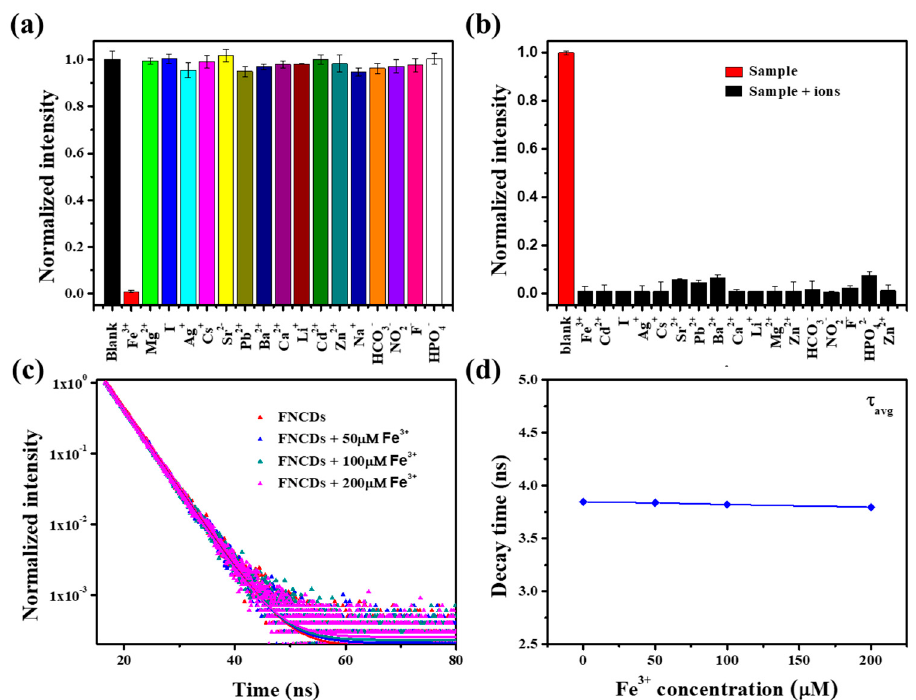
Figure 4. ( a ) Fluorescence intensity of FNCDs in the presence of different ions. ( b ) Change in the fluorescence intensity after adding different ions to the FNCDs/Fe 3+ reaction system. ( c ) Fluorescence lifetime spectra of FNCDs and FNCDs with different concentrations Fe 3+ (excitation and emission wavelengths: 450 and 512 nm). ( d ) The fluorescence lifetime of FNCDs after adding different concentrations of Fe 3+ .